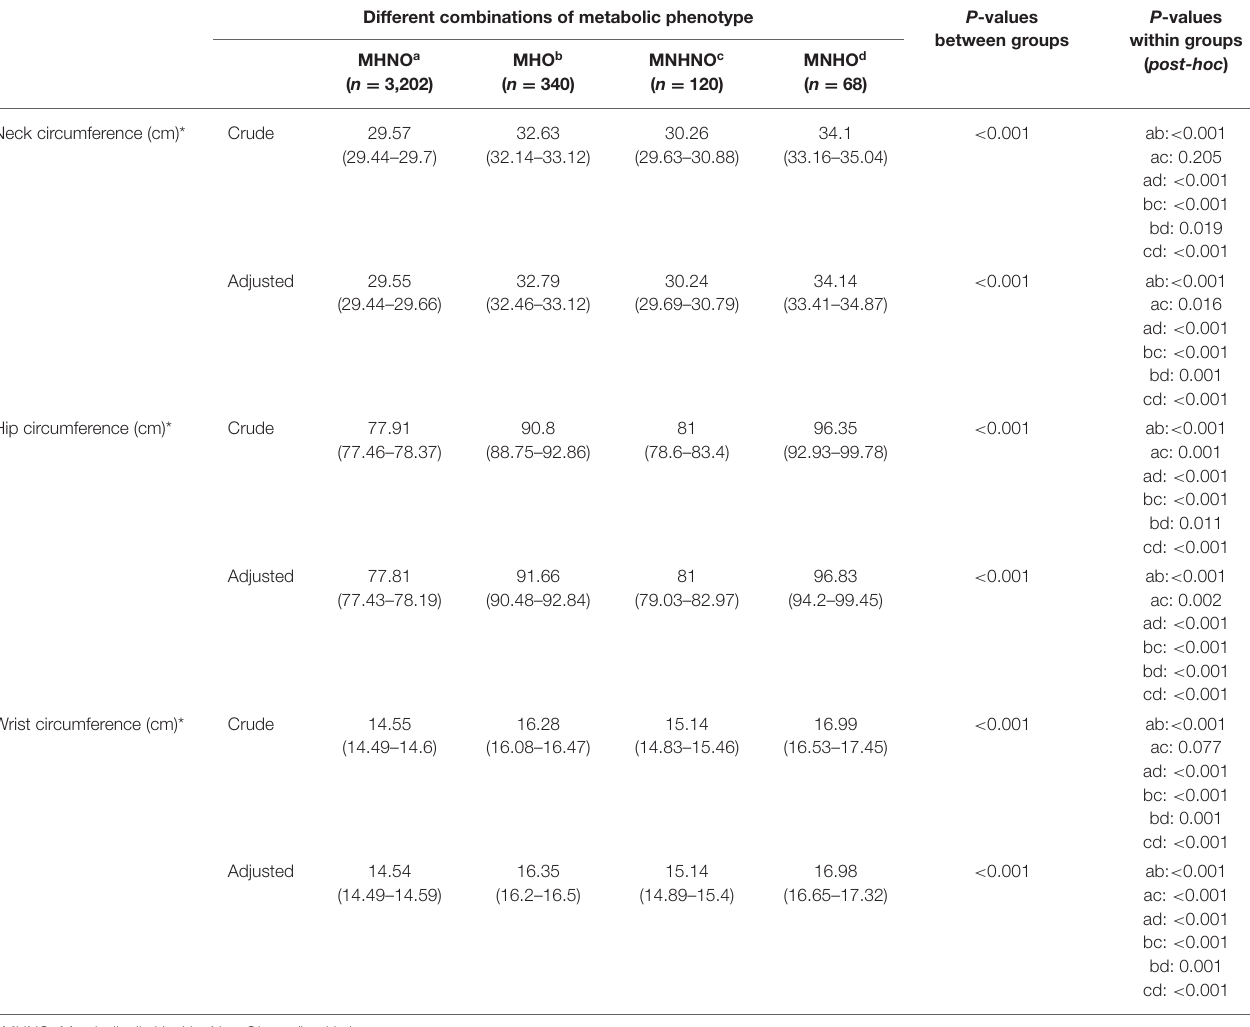
TABLE 3 | Means (95%) of hip, neck, and wrist circumference according to metabolic status: the CASPIAN-V study. Different combinations of metabolic phenotype P -values